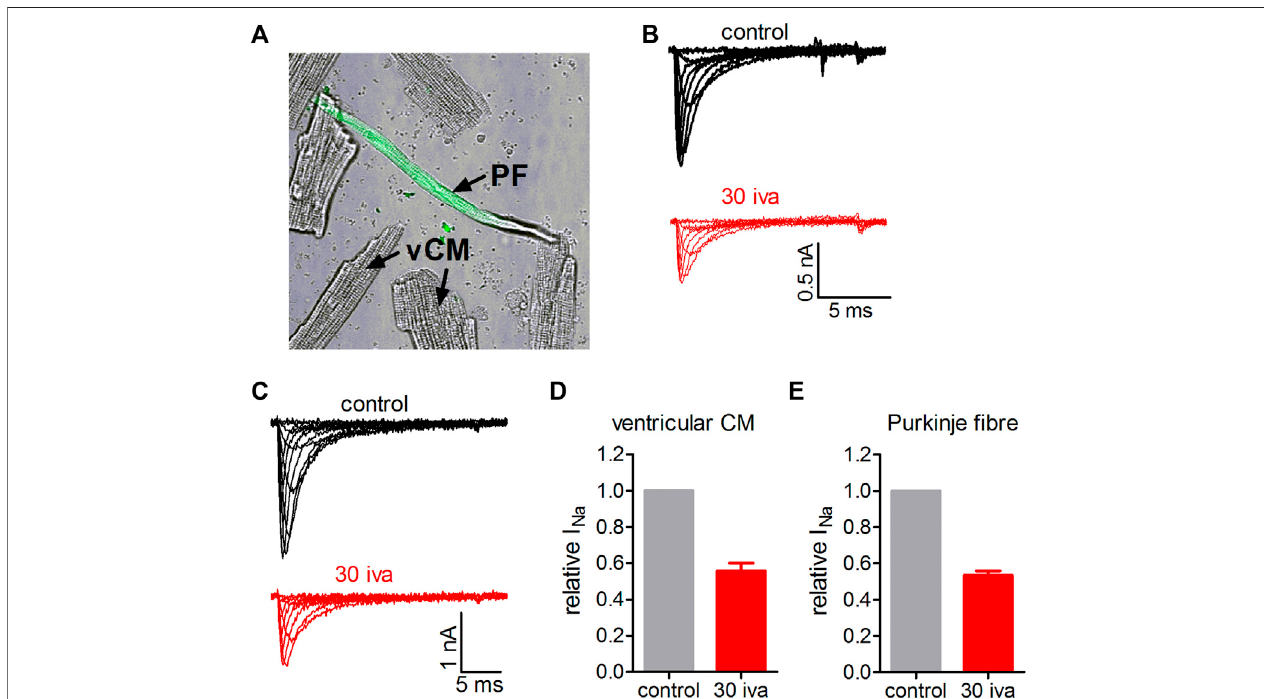
FIGURE 8 | Effect of ivabradine on VGSCs in primary cardiomyocytes isolated from the ventricles and the conduction system of the mouse heart. (A) Transmitted light(TM) imageof atypical ventricular cardiomyocyte (vCM) and acardiomyocyte isolated from the conduction system ofthe heart (Connexin40-eGFP positive Purkinje fi ber (PF); the green fl uorescent lightchannel is overlaid with TM channel). (B) Tyoical originalsodium current tracesin a ventricular cardiomyocyte elicited from a holding potentialof-70 mVbyvarious voltage stepsbetween − 60and+20 mV.Sodium currentsundercontrolconditionsand inthepresenceof30 µMivabradine(30 iva; in red). (C) As in B but for Connexin40-eGFP positive cardiomyocytes isolated from the cardiac conduction system. (D) Summary of fractional sodium current levels before (control) and after equilibration with 30 µM ivabradine derived from n = 7 ventricular cardiomyocytes. (E) Summary of fractional sodium current levels before (control) and after equilibration with 30 µM ivabradine derived from n = 7 Purkinje fi bers. Data are given as mean ±